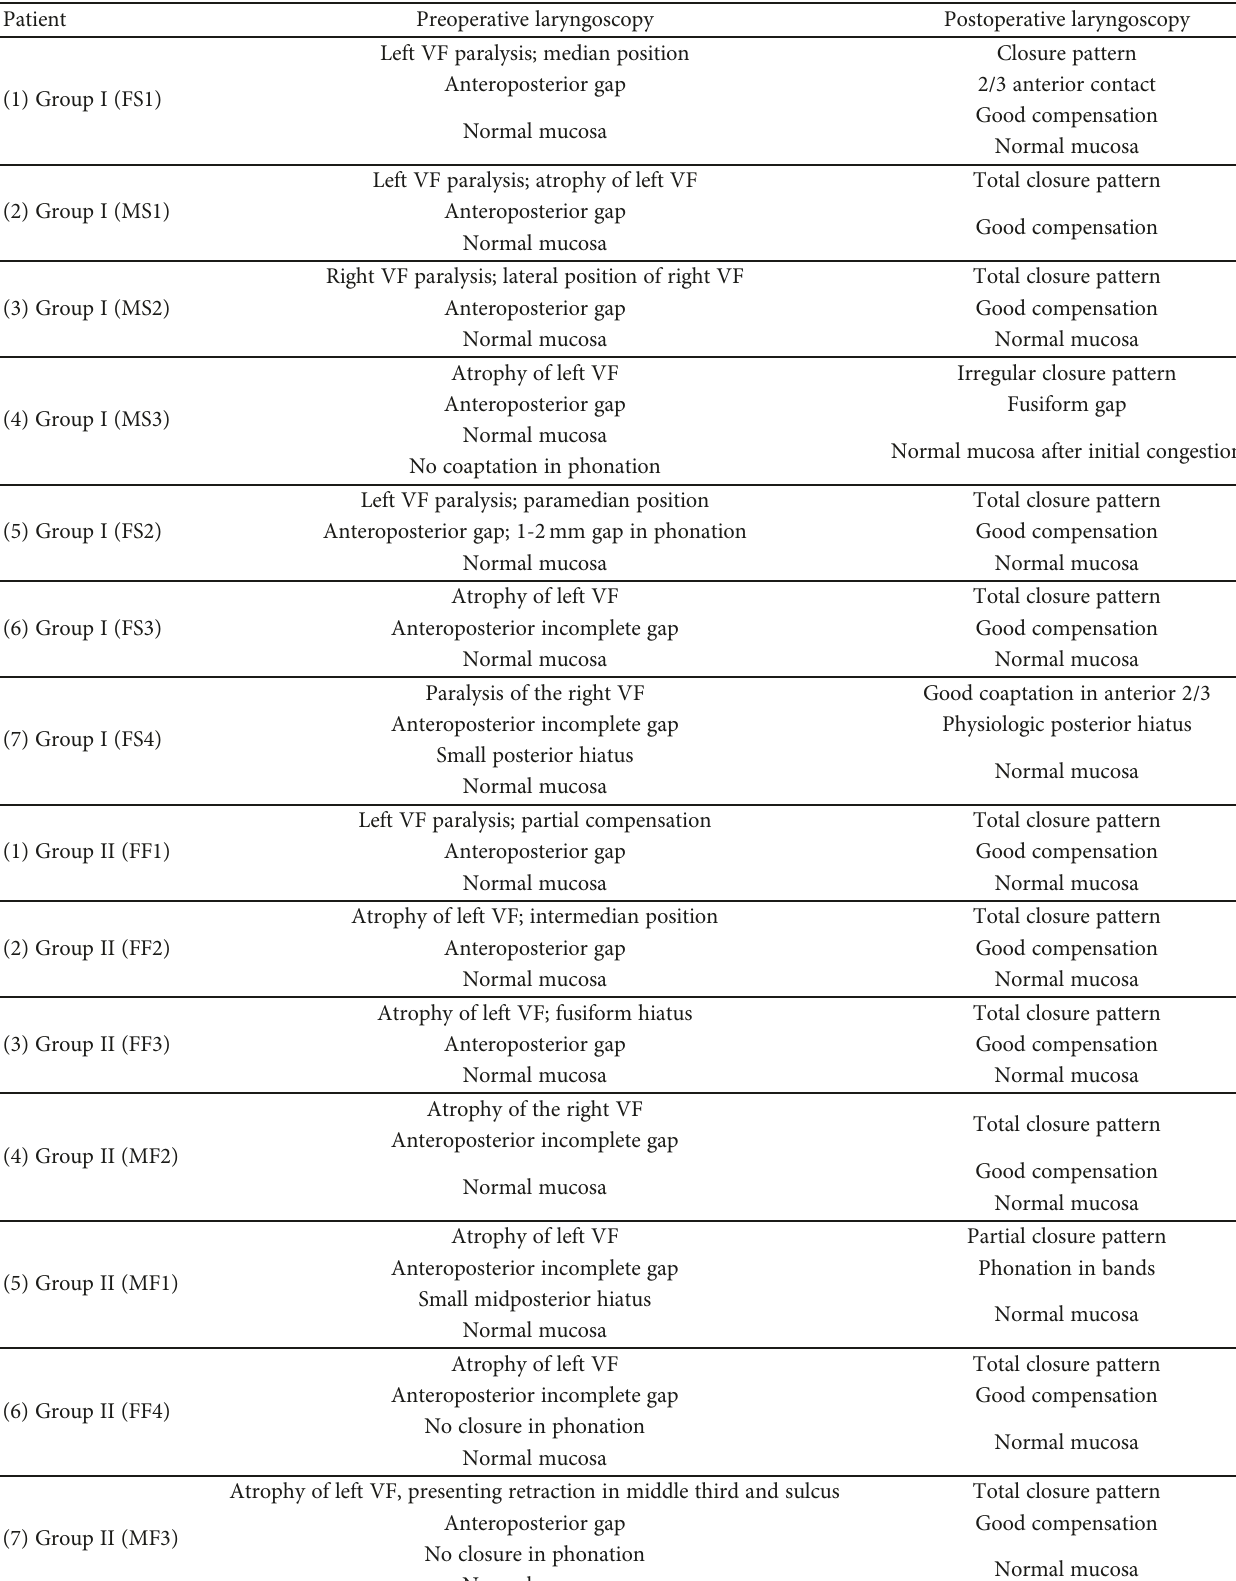
Table 5: Pretreatment and posttreatment descriptions from